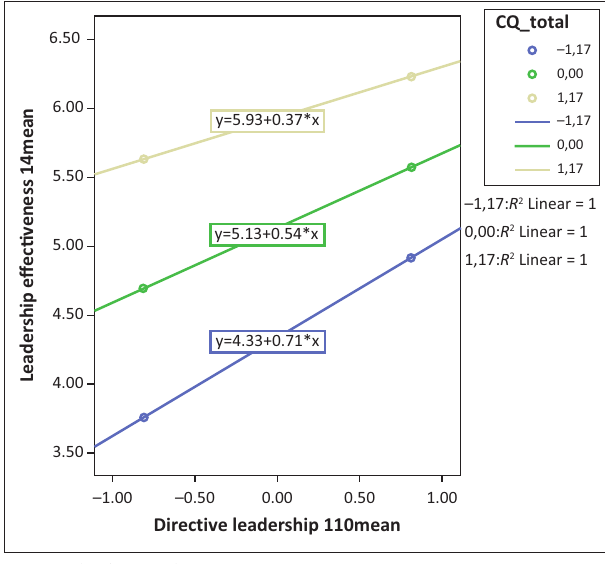
FIGURE 2: Leader cultural intelligence (aggregate) moderation on the relationship between directive leadership and leadership